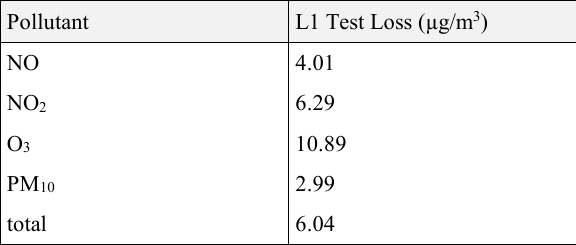
Table 1 : L1 test loss without weather